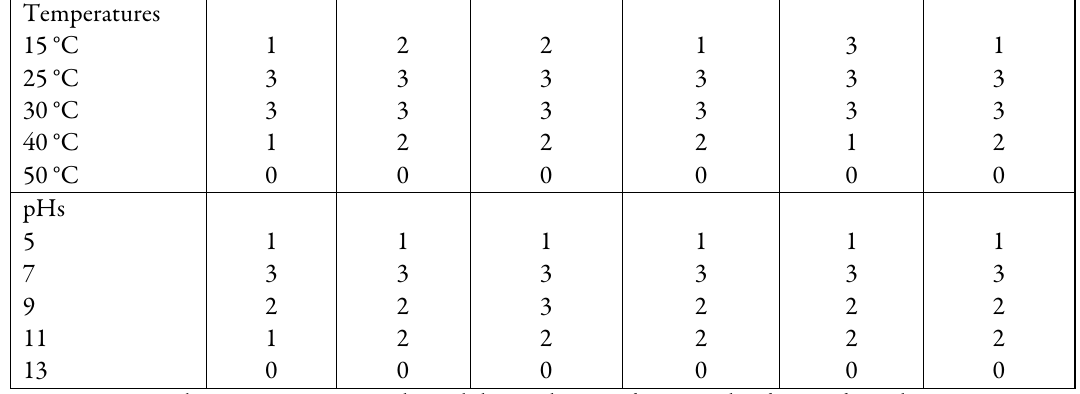
Table 5. Results of PGPR traits IAA production (µg mL -1 ) Isolate 1.25 mM 5 mM 19.82 ± 0.73 a 18.76 ± 0.57